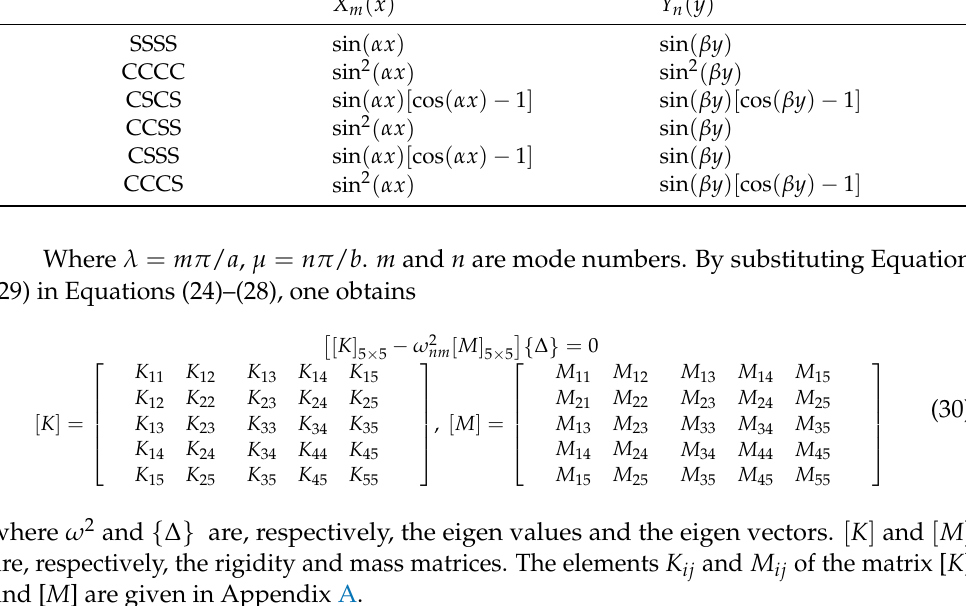
Figure 4. Variation of the non-dimensional frequency parameter (cid:3435)𝜔(cid:3557) = 𝜔ℎ(cid:3493)𝜌 (cid:3030) 𝐸 (cid:3030) ⁄ (cid:3439) with the material gradation index, P for simply supported Al/Al 2 O 3 functionally graded square plates and doubly curved shells ( a = b = 10 h , m = n = 1). 0